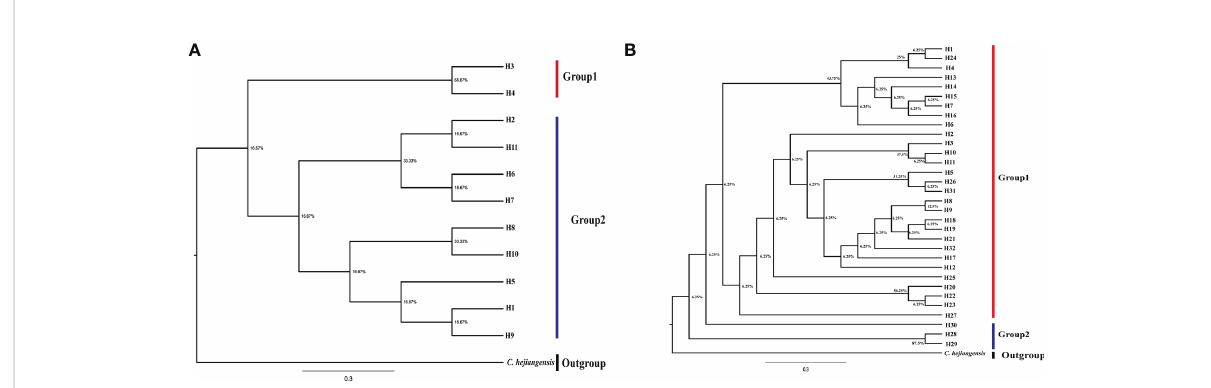
FIGURE 4 Phylogenetic Tree of Ch. utilis based on cpDNA (A) and nrDNA (B) haplotypes by IQ- tree.